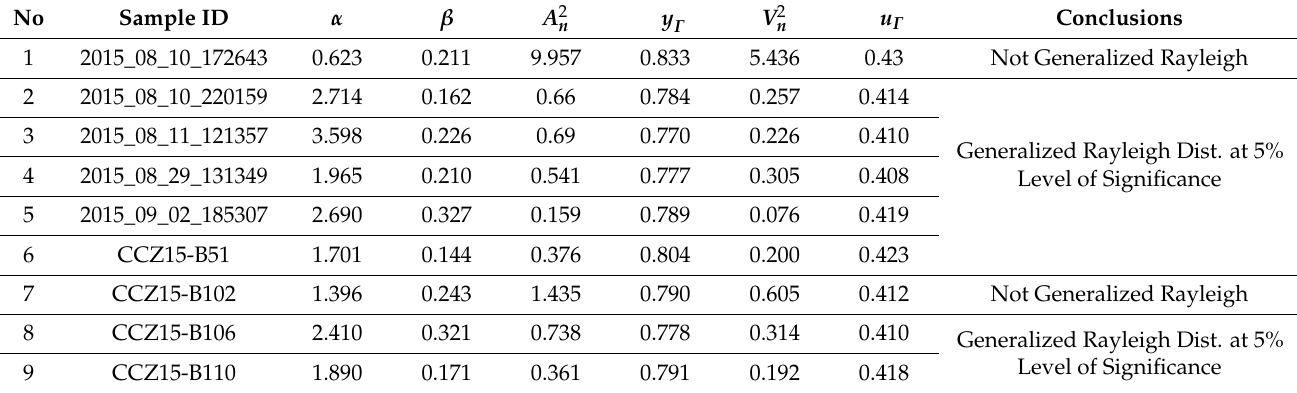
Table 3. Results of Goodness-of-Fit Test for 9 Sets of Samples of Nodule Long